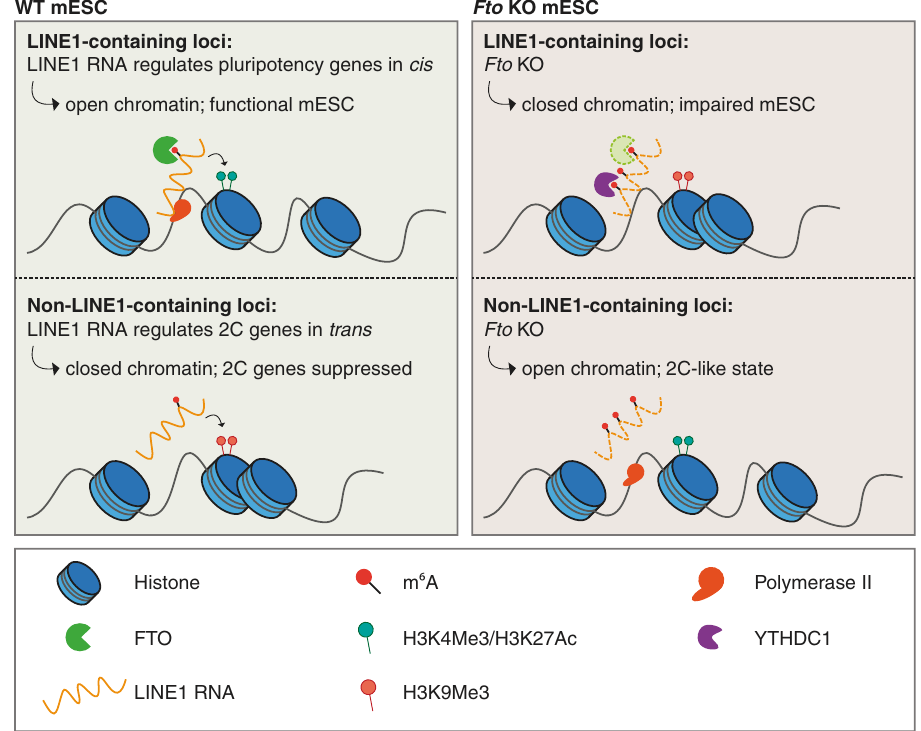
Fig. 1 Schematic representation of the function of LINE1 RNA in mESCs and consequences of Fto KO. LINE1 RNA is the main substrate of FTO in mESCs. In WT mESCs, LINE1 RNA promotes an open chromatin state at LINE1-containing gene loci, for example by recruitment of histone modi fi ers that install activation marks. Mechanistically, loss of FTO leads to an increase in m 6 A levels of LINE1 RNA, which causes destabilization and thereby reduced levels of LINE1 RNA, potentially via YTHDC1. The absence of LINE1 RNA and LINE1 RNA-DNA interaction affects the chromatin state and leads to closed chromatin, installation of repressive histone marks and reduced transcription. This phenomenon is especially observed at the site of LINE1-containing gene loci, which also encode pluripotency genes. These genes are regulated by LINE1 RNA in cis , leading to a decrease in expression upon Fto KO. LINE1 has been shown to be important for silencing of 2C genes. 3 Interestingly, a release of repression of non-LINE1-containing 2C genes is observed in Fto − / − mESCs, suggesting a potential role for LINE1 RNA in regulating these loci in trans . Functionally, this leads to a more 2C-like state and loss of the mESC state, including reduced expression of several pluripotency genes and impaired differentiation and